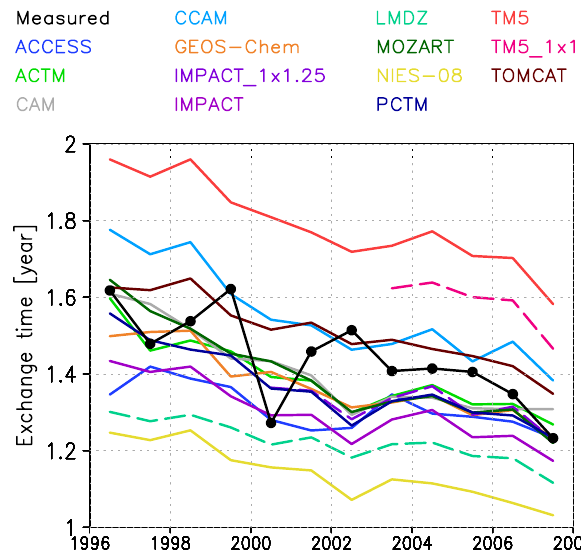
Fig. 8. IH exchange time ( τ ex ) estimated using the measured and simulated time series of average SF 6 in NH (BRW, MLO) and SH (CGO, SPO) by employing Eq. (4).